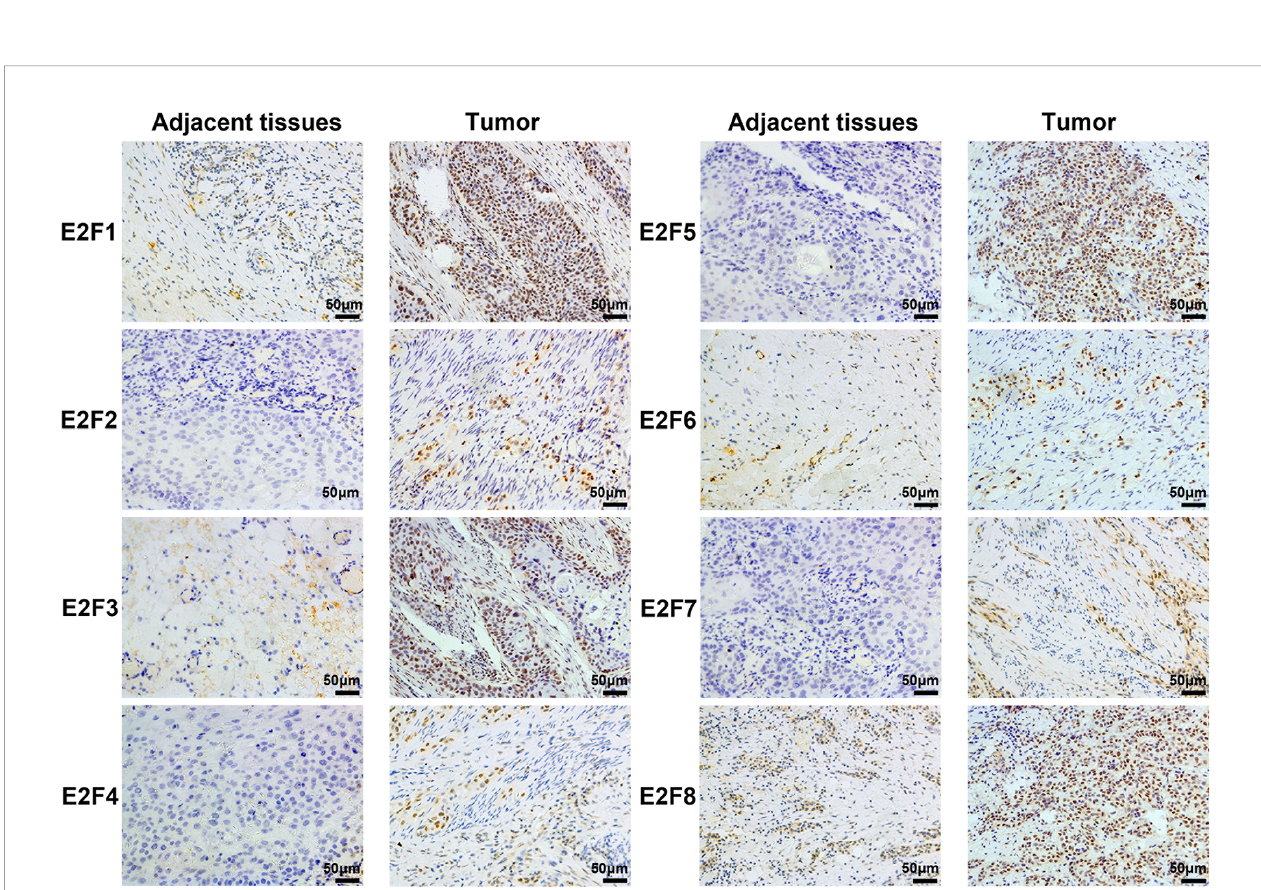
FIGURE 4 | The Expression of E2Fs in PAAD